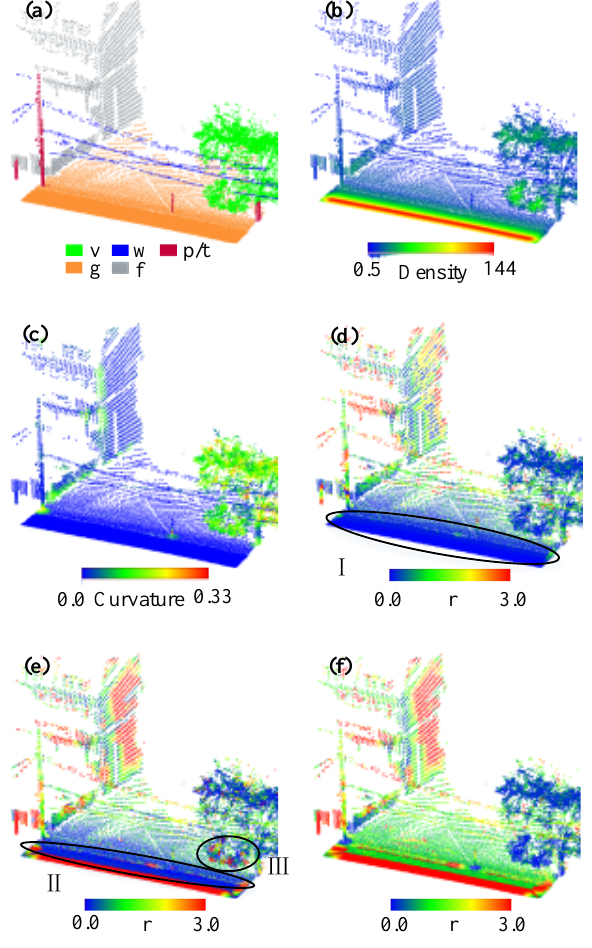
Figure 2. The distribution of the point cloud and the radius distribution for adaptive neighborhood. (a) Labeled point cloud (v: vegetation ; w: wire ; p/t: pole/trunk ; f: facade ; g: ground );